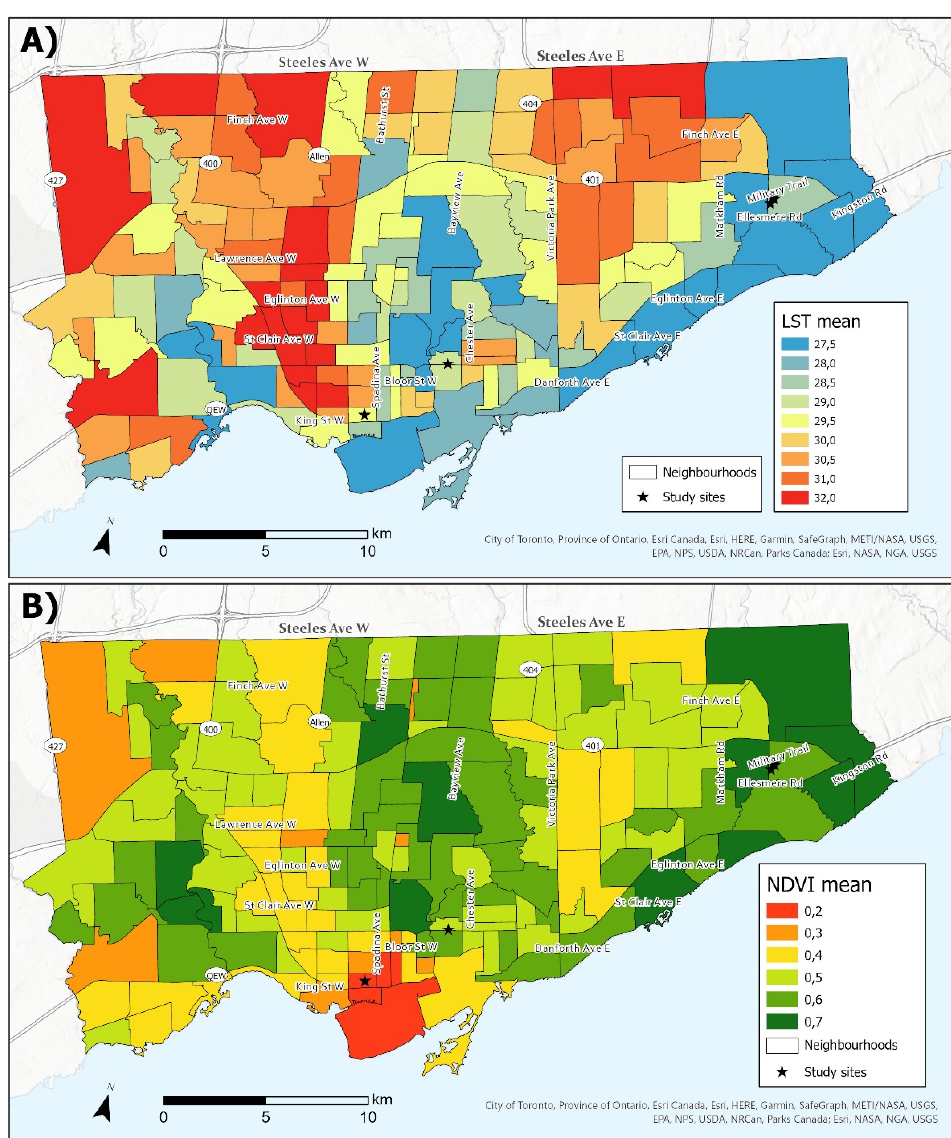
Figure 9. Spatial distribution of mean LST ( A ) and mean NDVI ( B ) on 24 August 2016 in City of Toronto neighbourhoods .